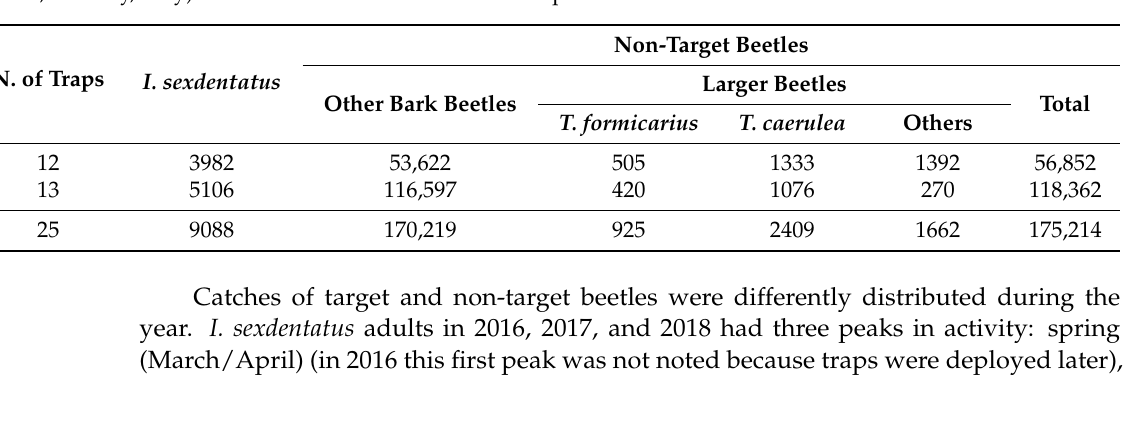
Table 2. Number of beetles trapped with the Ips sexdentatus aggregation pheromone during 2019 in the study site (Munici- pality of Grosseto, Tuscany, Italy) with standard and modified slot traps.